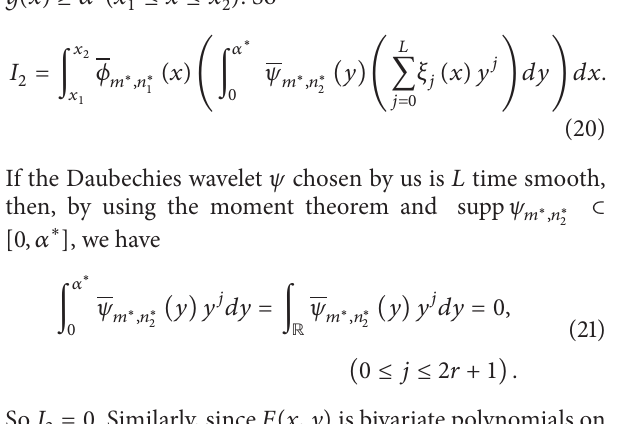
Figure 1: Partition of the complement of the domain Ω